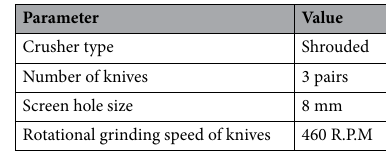
Table 2. The crusher specifications.